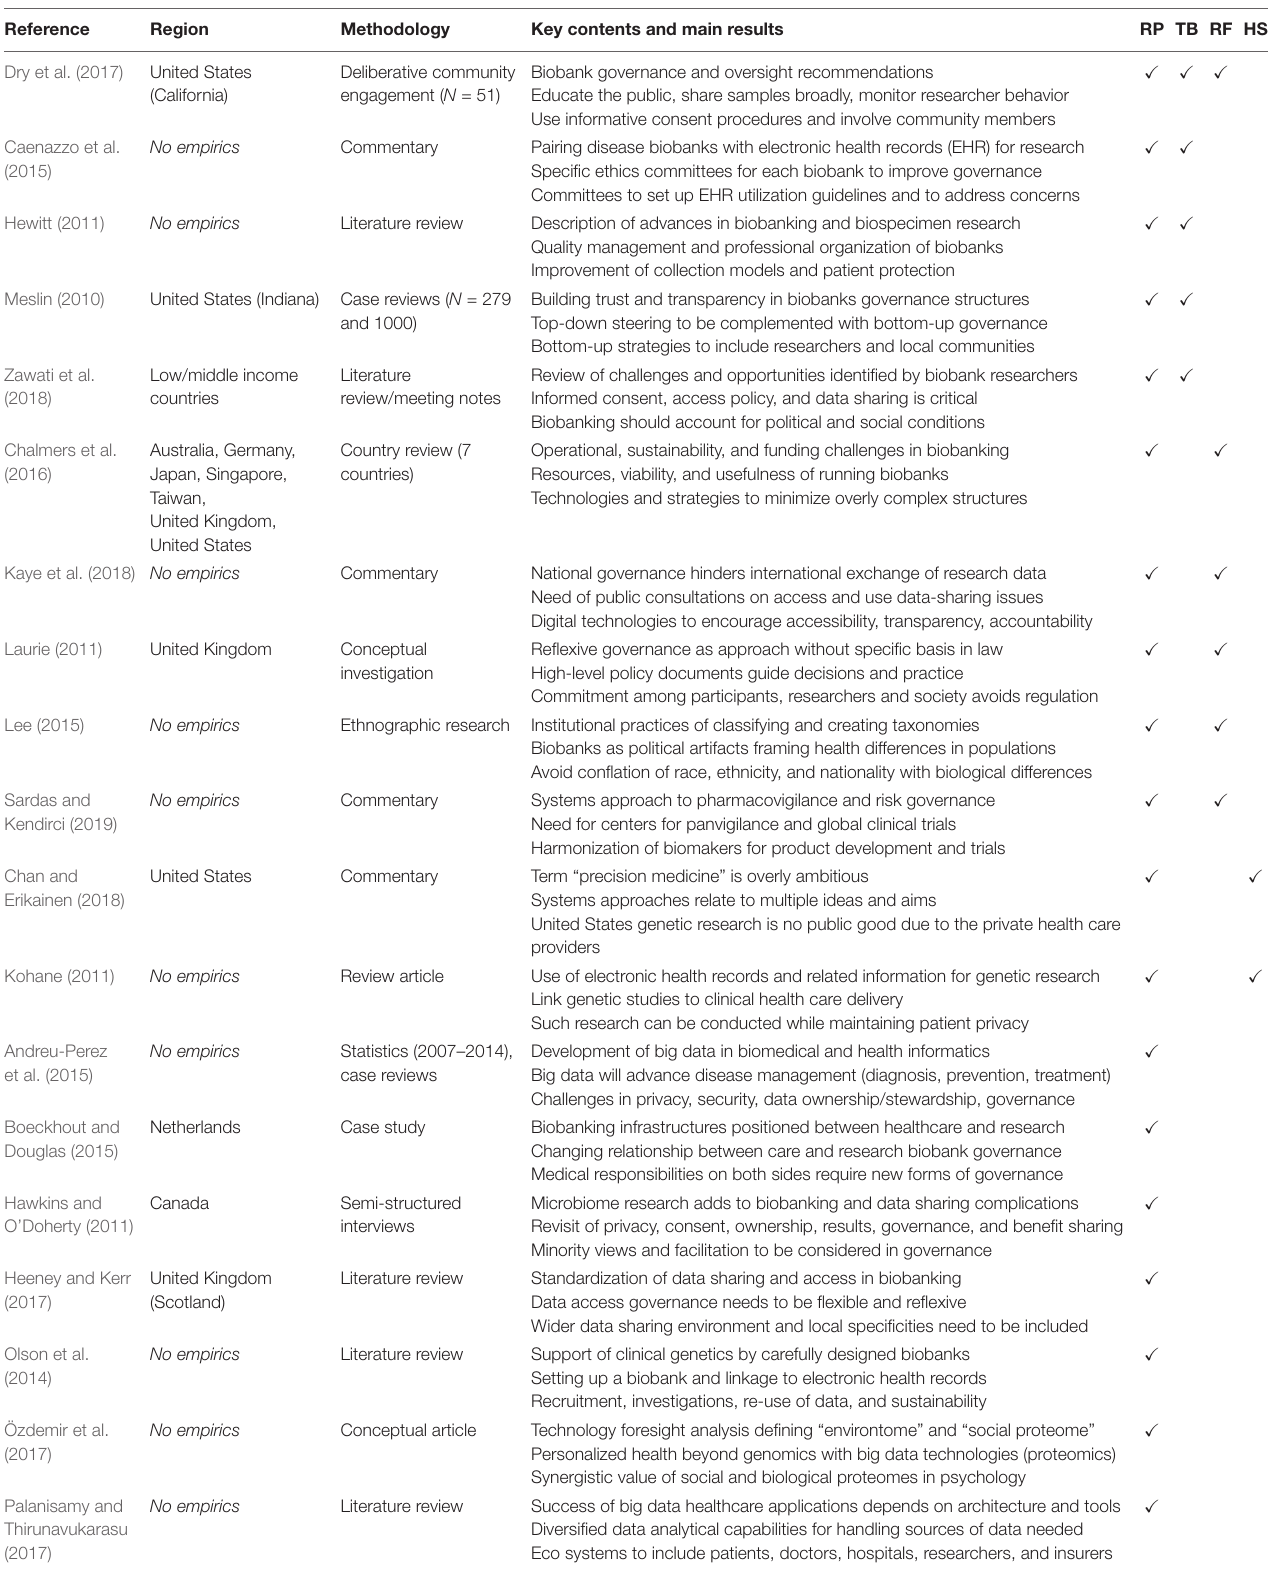
TABLE 2 | Synopsis of reviewed papers (Main corpus). Reference Region Methodology Key contents and main